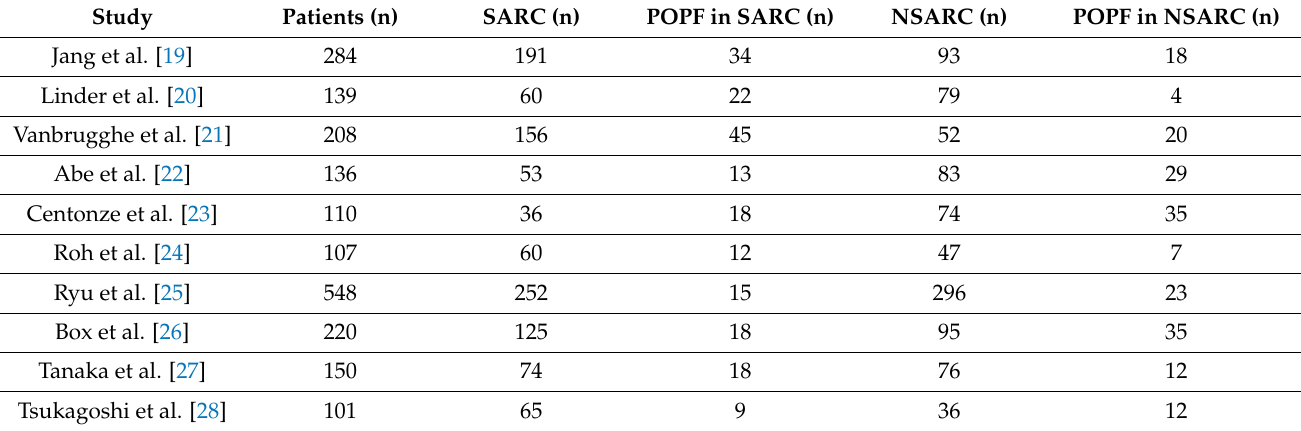
Table 4. Patients undergoing pancreatic surgery.